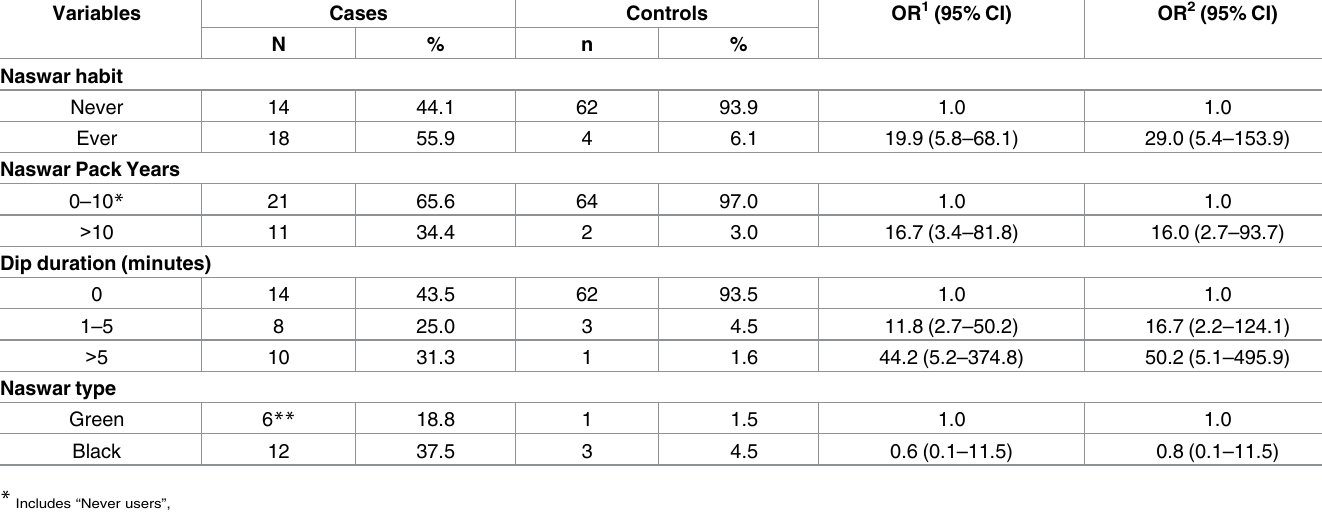
Table 5. Crude and adjusted risk estimates for oral cancer associatedwith Naswar use among women (32 cases, 66 controls) in Khyber Pakh- tunkhwa, Pakistan, derived from simple logistic regression.